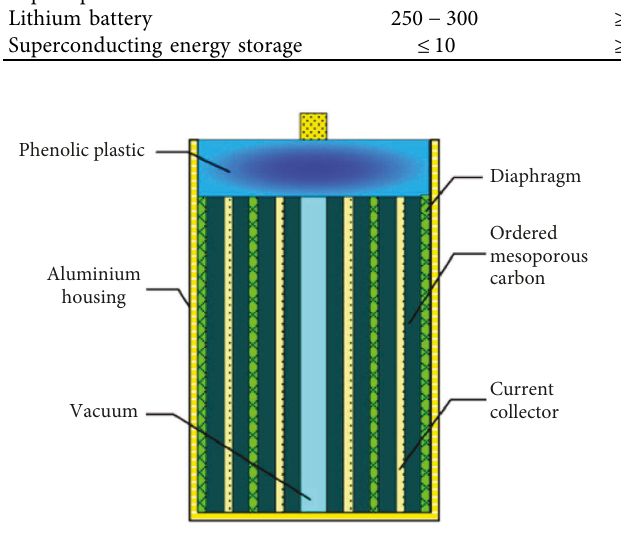
Figure 3: SC Structure